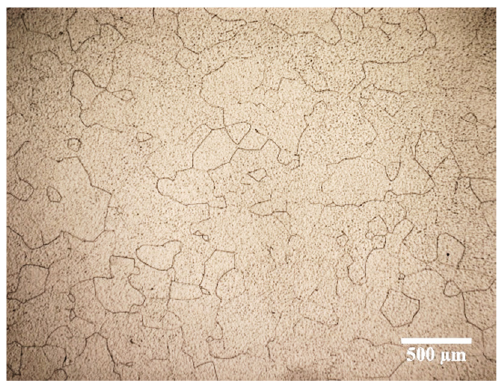
Figure 1. Microstructure of Ti55511 before deformation of a double ‐ cone sample at 950 °C. The samples were compressed at a deformation temperature of 950 °C using constant cross ‐ head speeds of 0.125 mm/s, 1.25 mm/s, and 12.5 mm/s, which provide nominal initial strain rates of 0.01/s, 0.1/s, and 1/s, respectively. A constant speed method was chosen instead of constant strain rate, to mimic the speed condition in most industrial forging compressed to a final height of about 5.0 mm. No lubricants were used for the test.